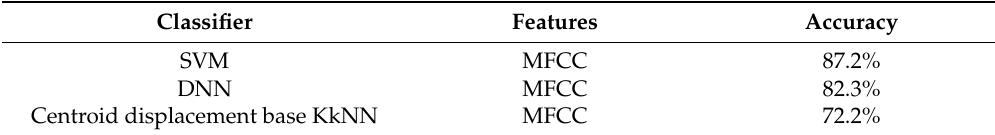
Table 2. Baseline results with MFCCs